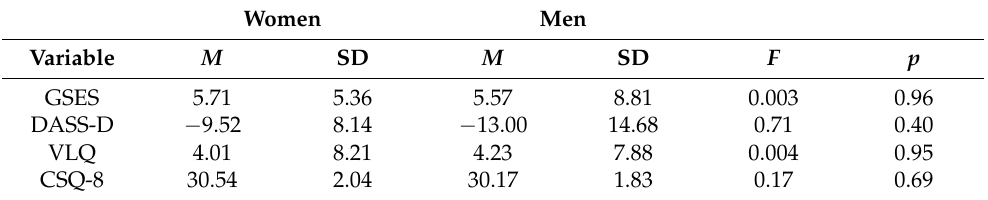
Table 4. Means, Standard Deviations, and One-Way Analyses of Variance for the Effects of Gender on Psychosocial Health and Satisfaction with Treatment.